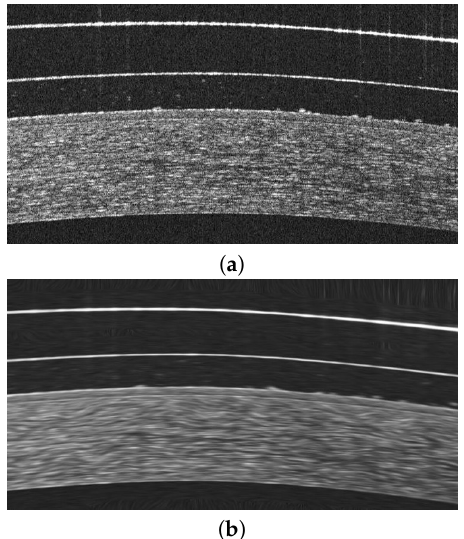
Figure 4. Example of application of the non-linear anisotropic diffusion filter. ( a ) Optical coherence tomography of the anterior segment (AS-OCT) image of the central region. ( b ) Result after the filtering